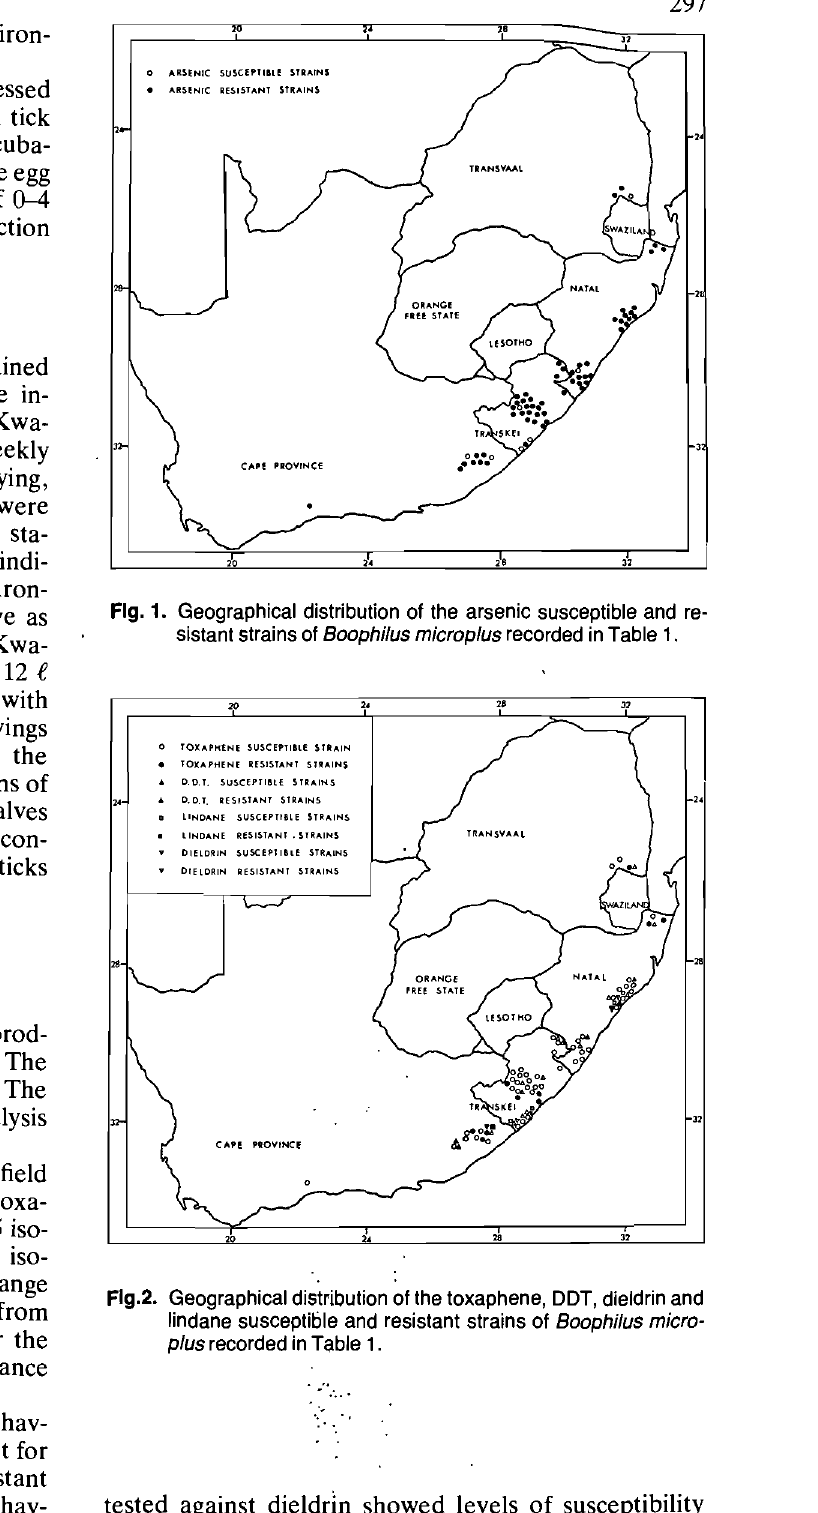
Flg.2. Geographical distribution of the toxaphene, DDT, dieldrin and lindane susceptible and resistant strains of Boophilus micro plus recorded in Table